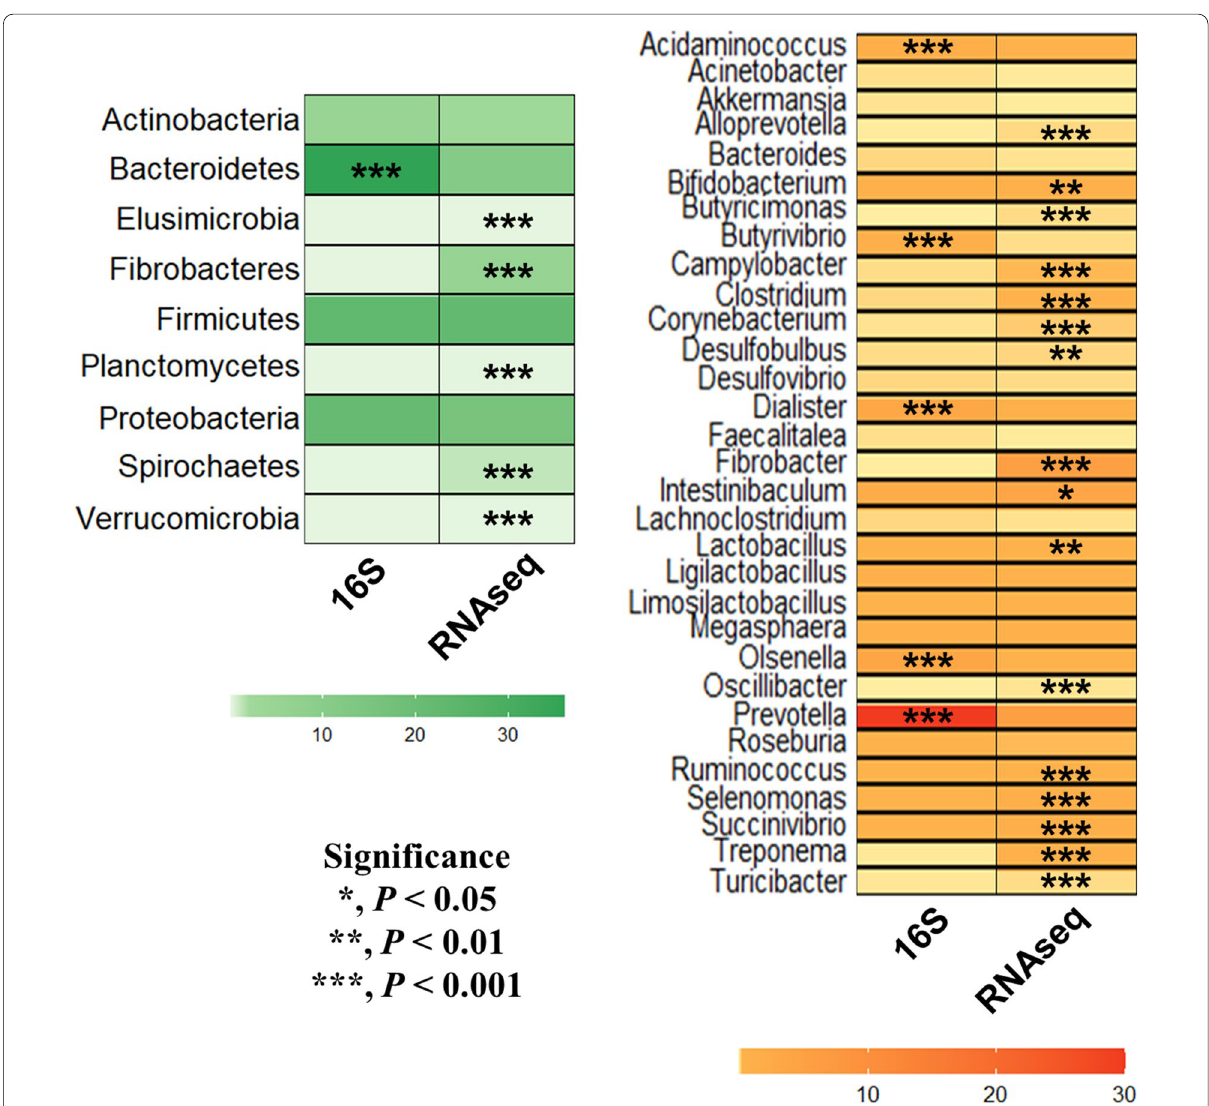
Fig. 1 Differentially abundant major bacterial taxa at phylum and genus levels detected by both the 16S amplicon-seq and RNA-seq. Only the shared taxa between two different sequencing strategies and major taxa (occupying over 0.01% average relative abundance in at least one of the analytic pipelines) were selected for the comparison. The intensity of the color represents the relative abundance (%) based on the color key on the